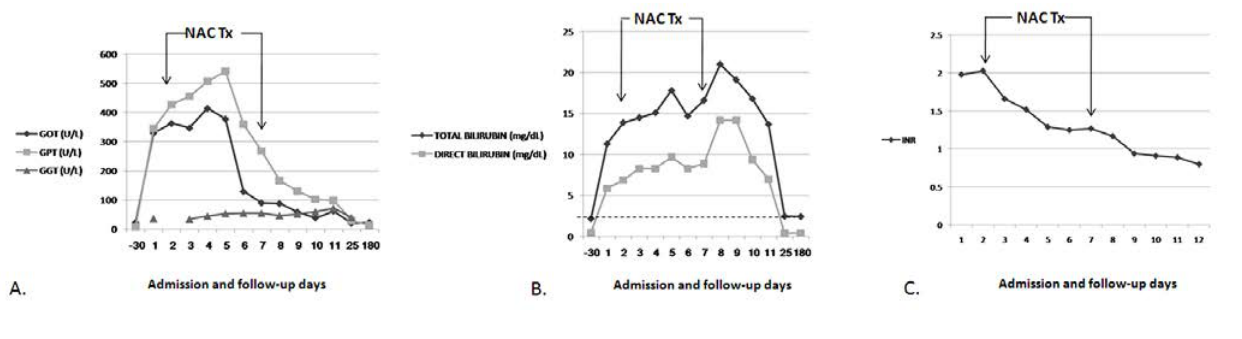
Figure 1. Changes of selected laboratory parameters during the course of the disease and follow-up. Intitiation and termination of N- acetylcysteine (NAC) treatment is indicated by arrows. A) Liver enzymes. B) Total and direct bilirubin. Dashed line indicates patient's baseline level of total bilirubin. C) International normalized